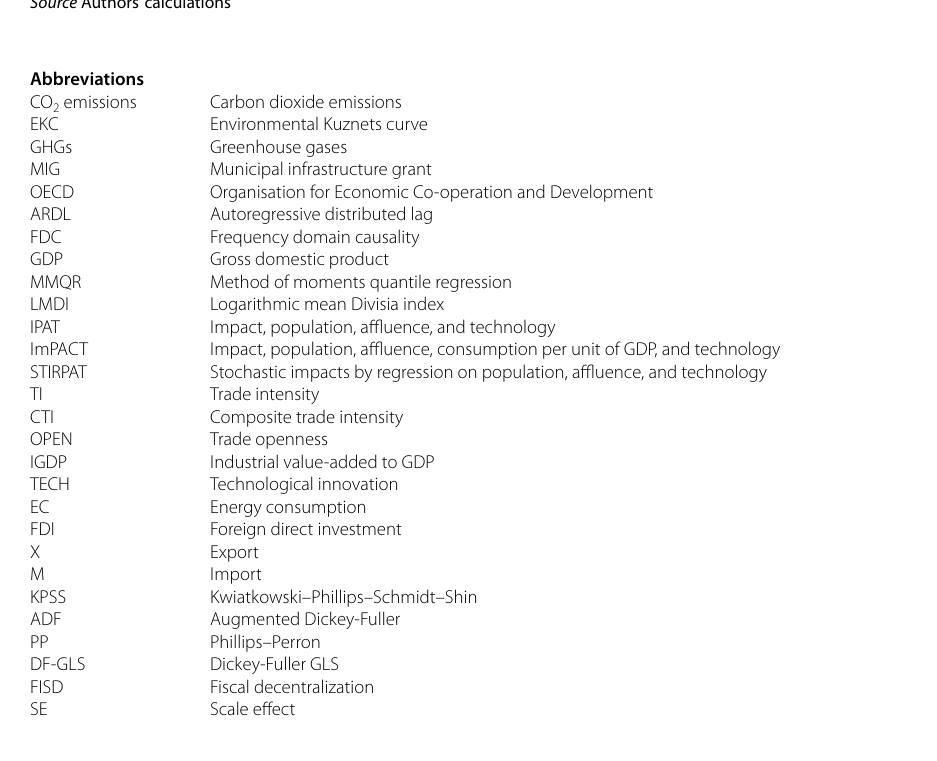
*, ** and *** denote statistical significance at 10%, 5% and 1% levels,